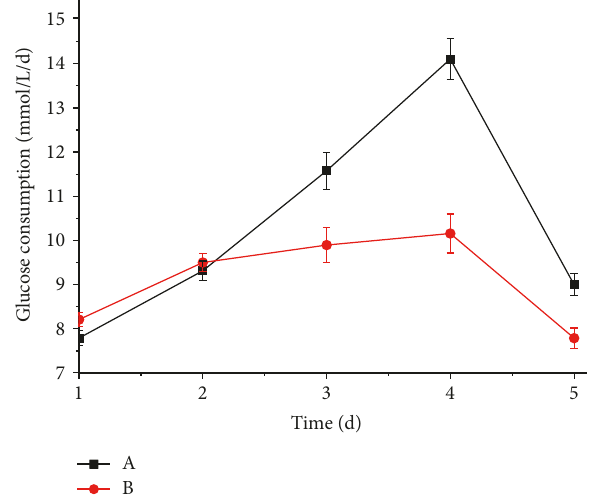
Figure 9: Cell counting of hepatocyte growth on spherical biocar- riers (A) and control medium (B).